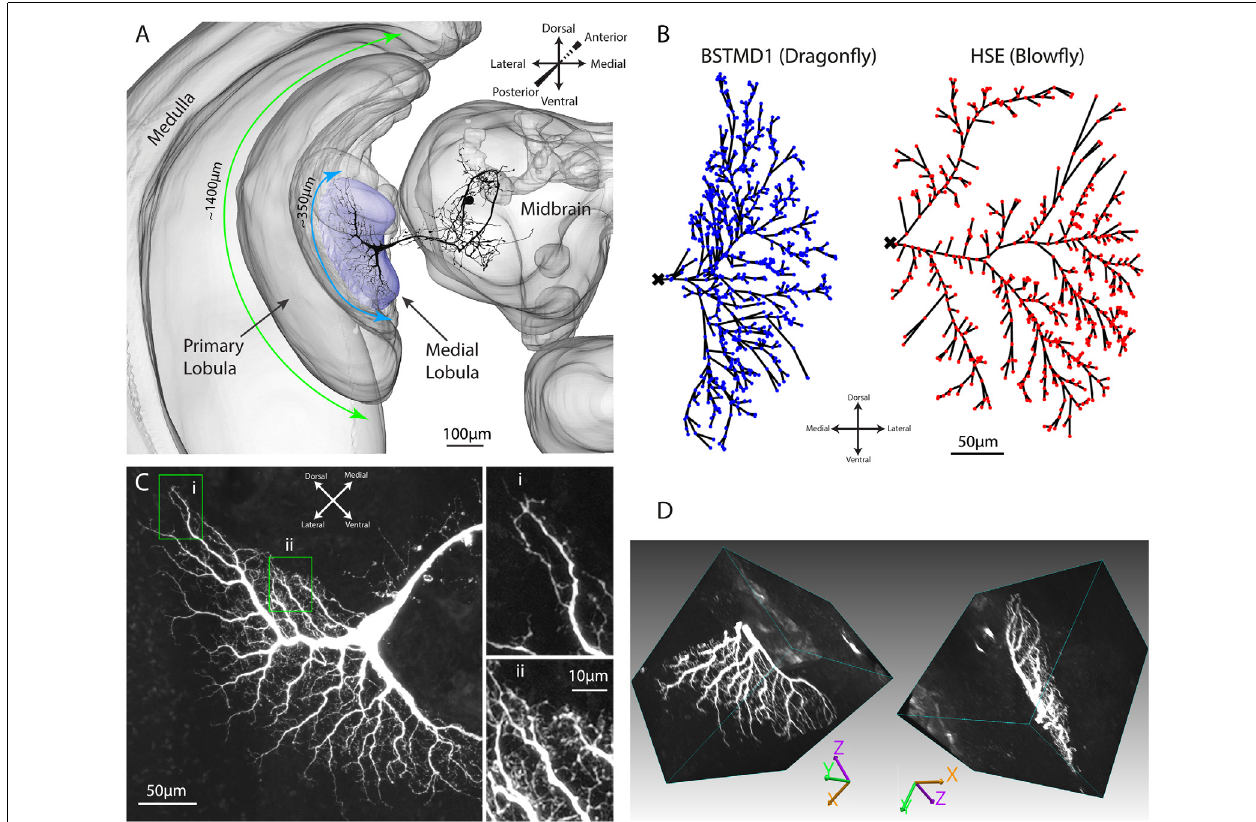
FIGURE 1 | Anatomy of the dragonfly brain and dendritic arborizations of BSTMD1. (A) A 3D reconstruction of the brain, based on a synapsin stained brain, showing the location and scale of the BSTMD1 neuron, with its main input arborization in the medial lobula. Green and blue arrows denote the approximate span of the outer part of the primary lobula and the medial lobula, respectively. (B) Z -projections from reconstructed 3D anatomical models for the main input arborization of the BSTMD1 neuron (left) and of an HSE neuron from the blowfly (right). The BSTMD1 model was based on data from the present study, while the HSE model used data downloaded from neuromorpho.org (Ascoli et al., 2007; Cuntz et al., 2008). The dots indicate the location at which NMDA receptors (or double exponential receptors) were placed within the arborizations in the multicompartment model. The ‘x’ marks the junction of the dendritic trees with the main arborization on the medial side of the tree, and also the location from which the membrane potential was estimated in subsequent multicompartment modeling. (C) Z -projection (maximum intensity) of a confocal image volume showing the main BSTMD1 arborization. Insets show higher magnification views of dense fine dendrites, featuring both dendritic spines and ‘blebs’ that lie beyond the resolution of the anatomical model in (B) . (D) Views of a rendered 3D volume image (opaque maximum intensity projection) from the ventral half of the arborization and rotated by different amounts. The volume is based on a high-resolution re-scan after vibratome sectioning. The left view approximately matches the Z -projection in (C)